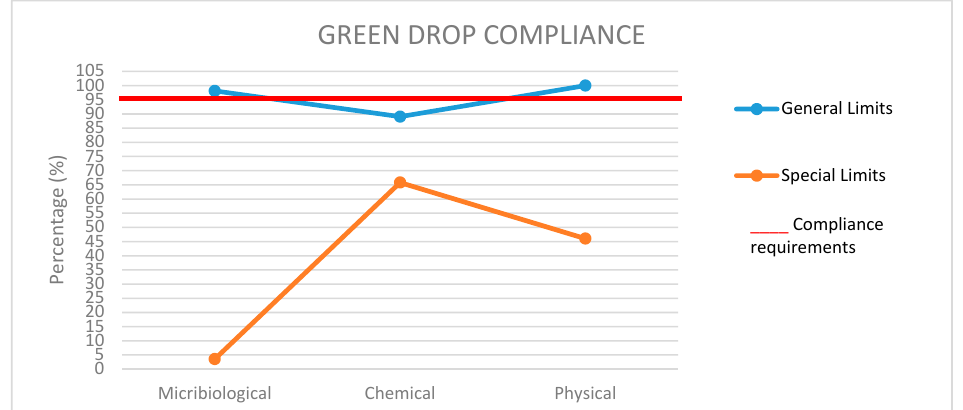
Figure 1. Assessment of the data to green drop compliance.